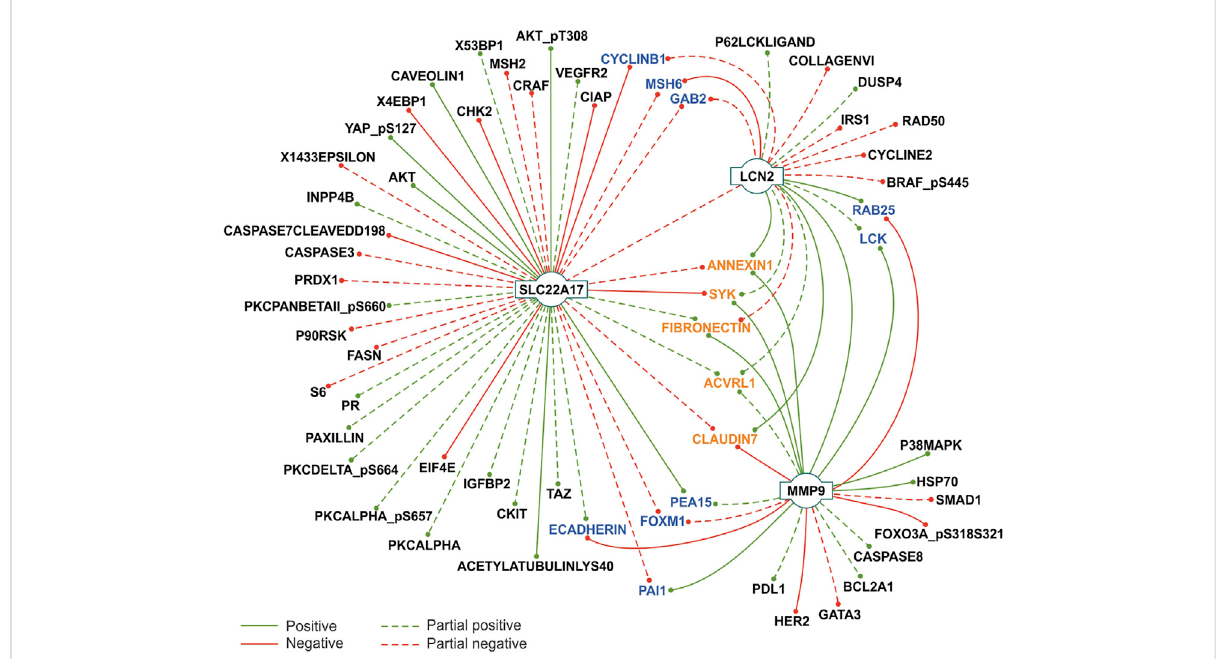
FIGURE 5 Correlationanalysisbetween LCN2 , SLC22A17 ,and MMP9 geneexpressionandproteinlevelsintumortypes.Protein-geneinteractionshowing correlation (Pearson ’ s r ≥ 0.3 or ≤ − 0.3; p ≤ 0.05) in at least fi ve tumor types are reported. The concordance among Pearson ’ s values was de fi ned as the degree of agreement among the correlation sign. Partial concordance: dotted interaction lines. Total concordance: solid interaction lines. Proteins interacting with two genes are represented in blue, while proteins interacting with all three genes are represented in orange. The network was obtained from Cytoscape 3.8.2